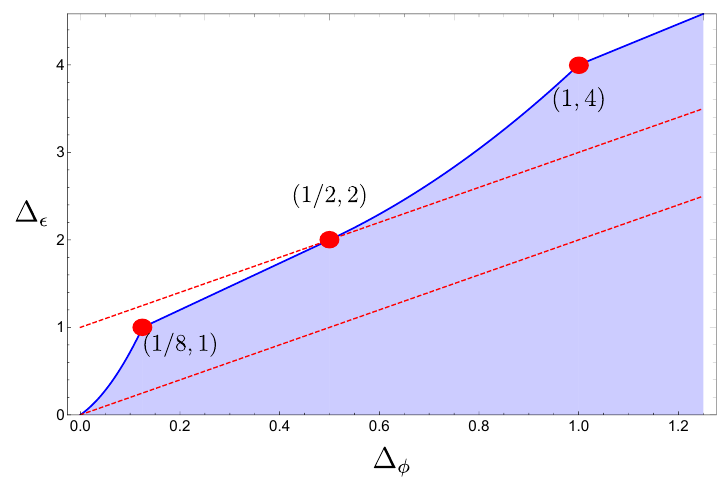
Figure 9 . Schematic bound on leading scalar dimension (cid:1) (cid:15) in 2D CFTs. Three notable points ((cid:1) (cid:30) ; (cid:1) (cid:15) ) are the 2D Ising model h (cid:27)(cid:27)(cid:27)(cid:27) i correlator at (1 = 8 ; 1), the large m limit of the minimal model (cid:30) four-point correlator at (1 = 2 ; 2) and the 2D Ising h (cid:15)(cid:15)(cid:15)(cid:15) i correlator at (1 ; 4). The dashed 1 ; 2 lines correspond to the 1D generalized free fermion ((cid:1) (cid:15) = 1+2(cid:1) (cid:30) ) and boson ((cid:1) (cid:15) = 2(cid:1) (cid:30) ) theories.